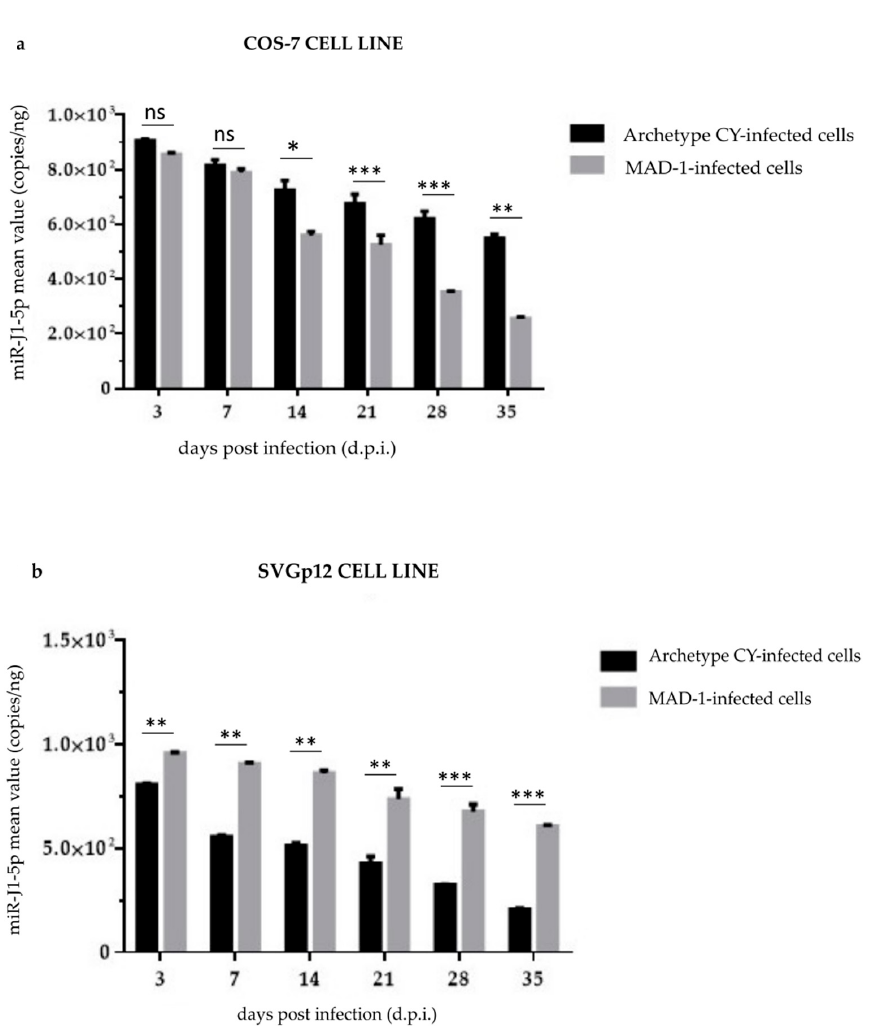
Figure 2. miR ‐ J1 ‐ 5p expression in the CY ‐ and MAD ‐ 1 ‐ infected COS ‐ 7 and SVGp12 cell lines: ( a